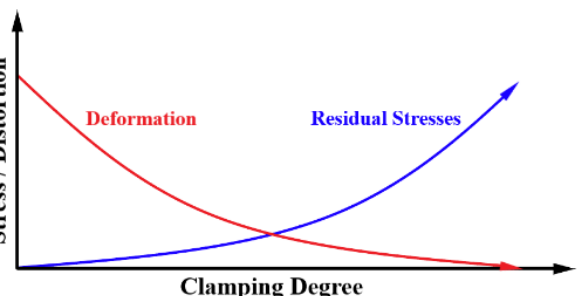
Figure 1. Relationship between clamping degree and the level of distortion as well as the effect on residual stresses [22].